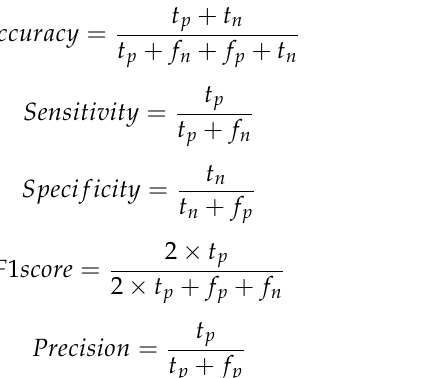
Table 2. The number of training and testing subjects used for each of the evaluation approaches. Training Testing Approach COVID-19 Normal COVID-19 Normal Public dataset 545 1266 167 317 Fused dataset 842 1266 238 317 Public dataset for training and local dataset for testing 545 1266 368 317 Fused dataset for training and local dataset for testing